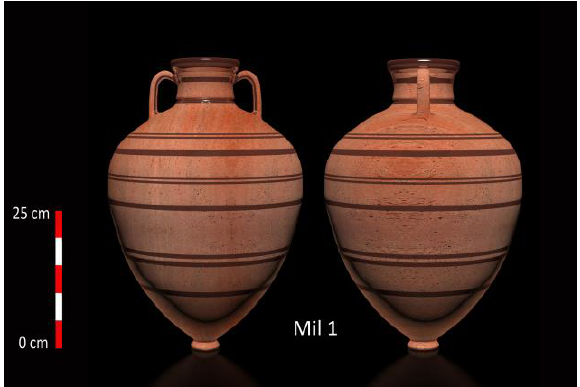
Figure 10. A Milesian amphora from 6 th century BC.